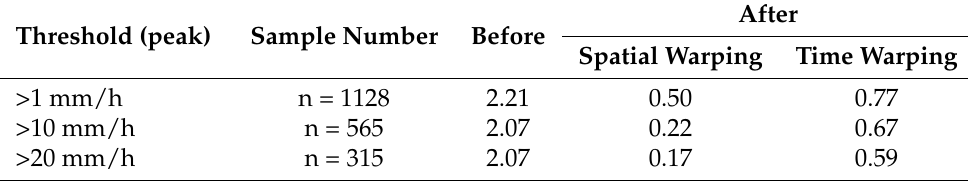
Table 3. Average absolute timing error before and after warping. The average is over all pixels recording at least one time step with more rainfall than a certain threshold according to v (and with nonzero rainfall according to u